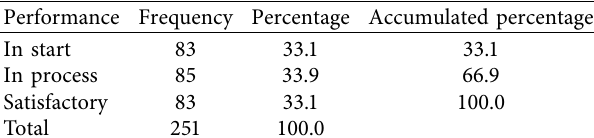
Table 4: Academic performance in mathematics.